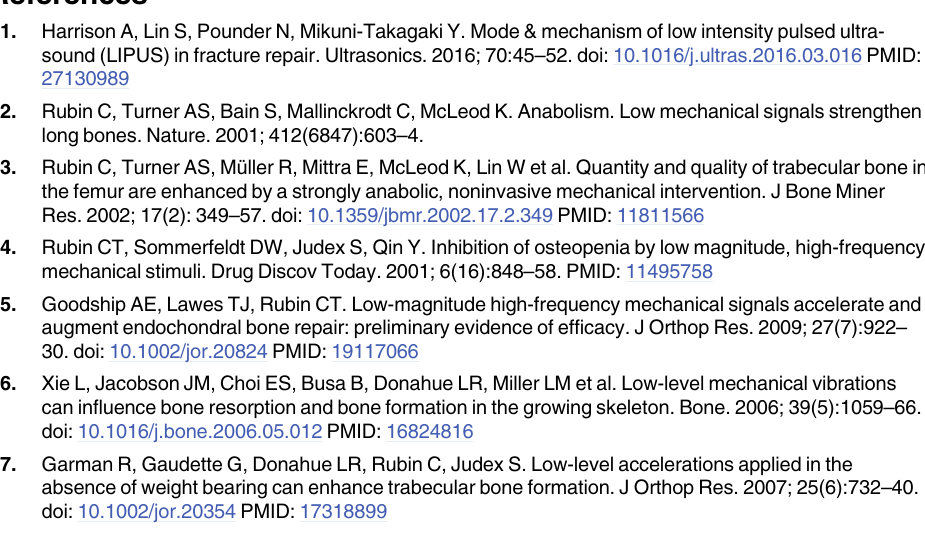
S2 Fig. Radiographic images of all fractured-ribs in divided 5 groups. Control (vibration), low-magnitude and high-magnitude acceleration groups in the vibration acceleration study, and control (constant) and centrifuge acceleration groups in the constant acceleration study. Low: low-magnitude acceleration group, High: high-magnitude acceleration group, Centri- fuge: centrifugal acceleration group. Union: union ribs (left column), Non-union: non-union ribs (right column). (No union ribs in high-magnitude vibration acceleration group).